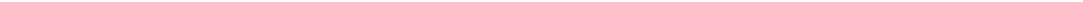
(see fi gure on previous page) Fig. 6 PD-L1 K263 acetylation abrogates its unclear translocation. a Western blot analysis of anti-PD-L1 IPs derived from MUM2B, MEL290 and A375 cells to detect PD-L1 acetylation levels. b Western blot images showing the protein levels of EP300 and HDAC2 in MUM2B, MEL290 and A375 cells. c Western blot analysis of anti-PD-L1 IPs derived from MUM2B and MEL290 cells treated with the indicated constructs to detect PD-L1 acetylation levels. d , e Western blot analysis of cytoplasmic/membrane (C/M) and nuclear (N) fractions of PD-L1 in MUM2B ( d ) and MEL290 ( e ) cells transduced with si-EP300. f ChIP-qPCR assay of the PD-L1 status at the EGR1 promoter in MUM2B and MEL290 cells transduced with si-EP300. g Western blot images showing the protein levels of EGR1 and VEGFA in MUM2B and MEL290 cells transduced with si-EP300. h , i Western blot analysis of cytoplasmic/membrane (C/M) and nuclear (N) fractions of PD-L1 in MUM2B ( h ) and MEL290 ( i ) cells treated with 50 μ M HDAC2i (santacruzamate A) for 24 h. j ChIP-qPCR assay of the PD-L1 status at the EGR1 promoter in MUM2B and MEL290 cells treated with 50 μ M HDAC2i for 24 h. k Western blot images showing the protein levels of EGR1 and VEGFA in MUM2B and MEL290 cells treated with 50 μ M HDAC2i for 24 h. l Western blot analysis of cytoplasmic/membrane (C/M) and nuclear (N) fractions of PD-L1 in MUM2B cells treated with the indicated constructs. m Statistical analysis of nPD-L1 levels in MUM2B cells treated with the indicated constructs. n = 3. Data are presented as means ± SD. Two-tailed unpaired Student ’ s t -test. n IF staining of PD-L1 in MUM2B cells treated with the indicated constructs. Left panel, representative IF staining images. Scale bars, 10 µm. Right panel, co-localization analysis of PD-L1 and DAPI by ImageJ software. o Statistical analysis of nPD-L1 fl uorescence intensity (%) in Fig. 6n. n = 20. Data are presented as means ± SD. Two-tailed unpaired Student ’ s t -test. p Western blot images showing the protein levels of EGR1 and VEGFA in MUM2B cells treated with the indicated constructs. q Schematic diagram showing that PD-L1 nuclear translocation was mediated by HDAC2-dependent PD-L1 K263